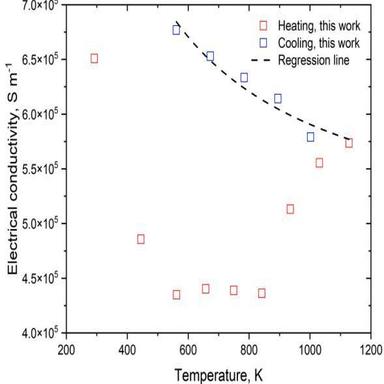
Electrical conductivity of annealed UFe3B2 sample measured by the fourpoint method.